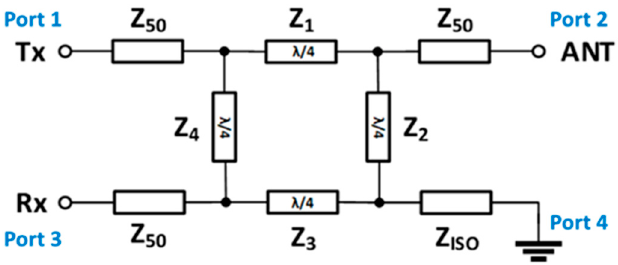
Figure 1. Block diagram of the proposed quasi-circulator using an asymmetric branch-line coupler.